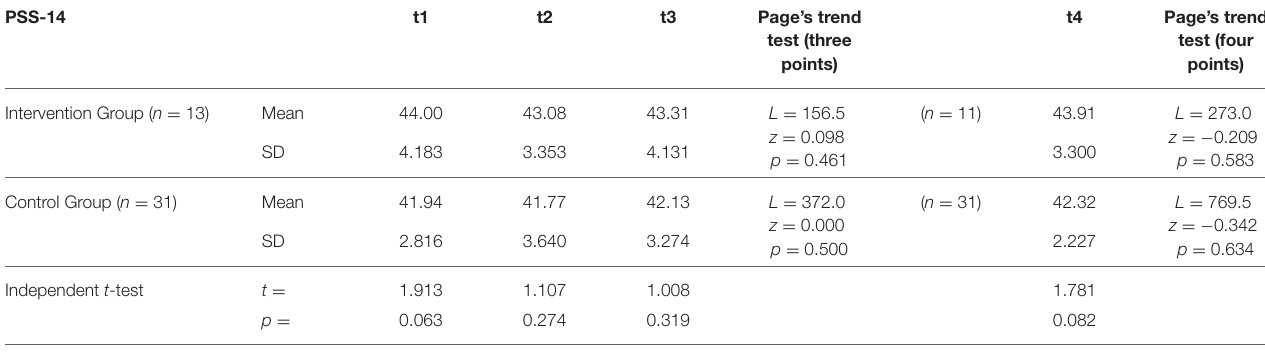
TABLE 2 | Perceived Stress Scale 14.